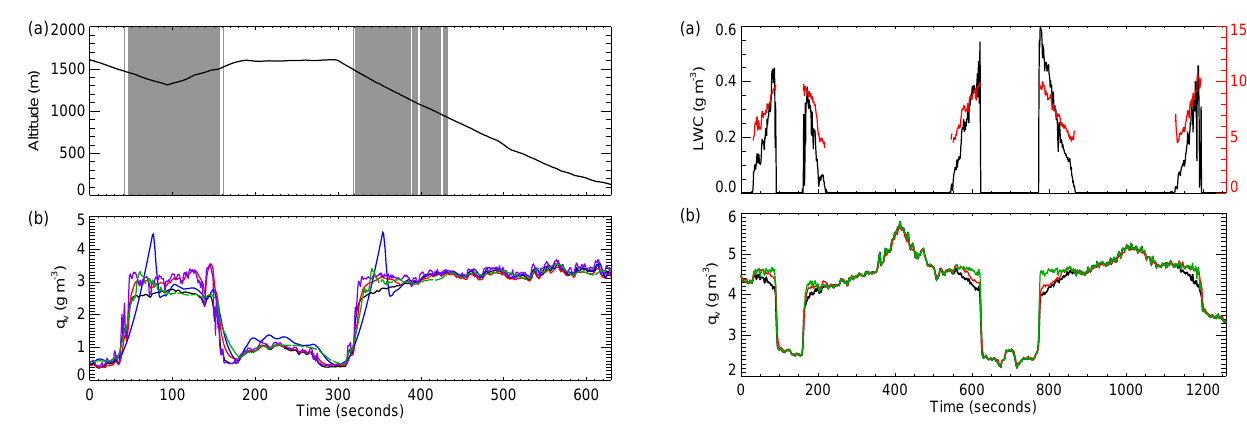
Figure 5. Time series from flight B668 when the aircraft was pro- filing in and out of a moist boundary layer with much drier air above. The top panel shows the aircraft altitude with periods in cloud shaded in grey. The lower panel shows absolute humidity from the Buck (green), GE (blue), TWC (purple), wvssF (black) and wvssR (red).